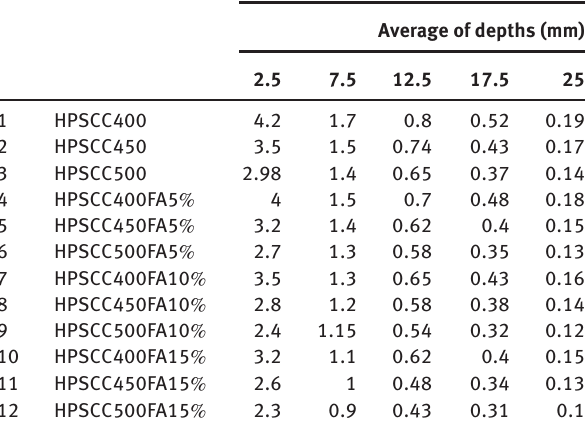
Table 11 Chloride ion percentage at different average depths of the concrete samples.